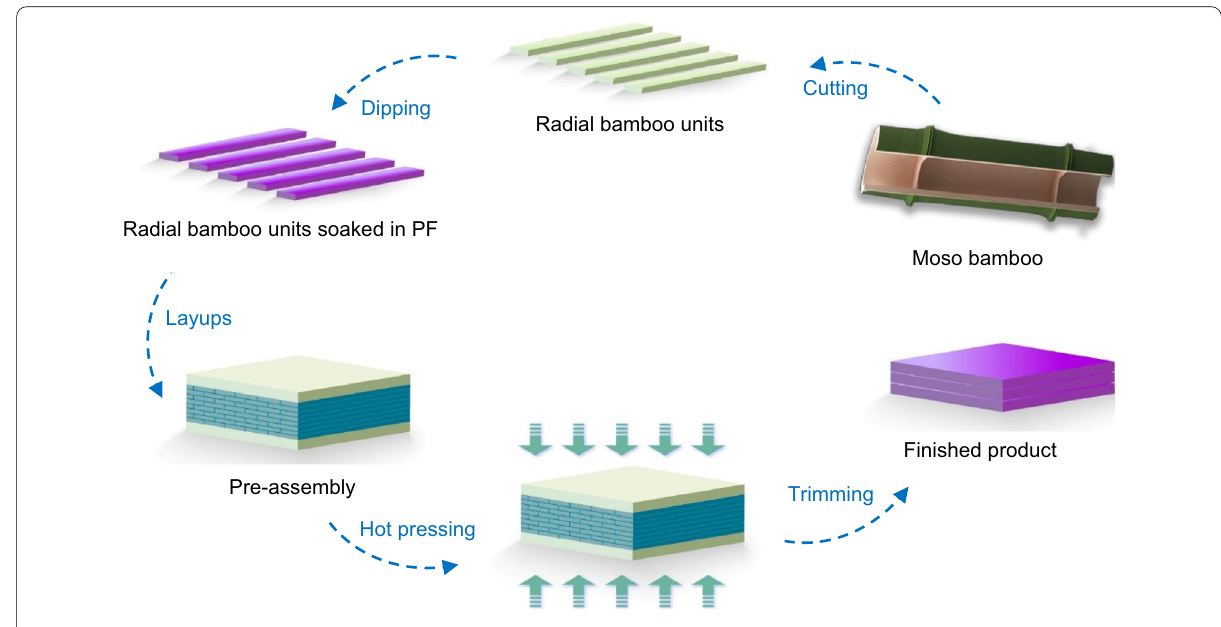
Fig. 4 Technological